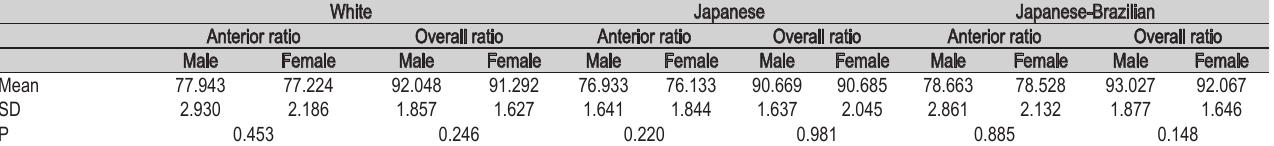
Table 1 - Intersex differences for anterior and overall tooth size ratios (t tests).